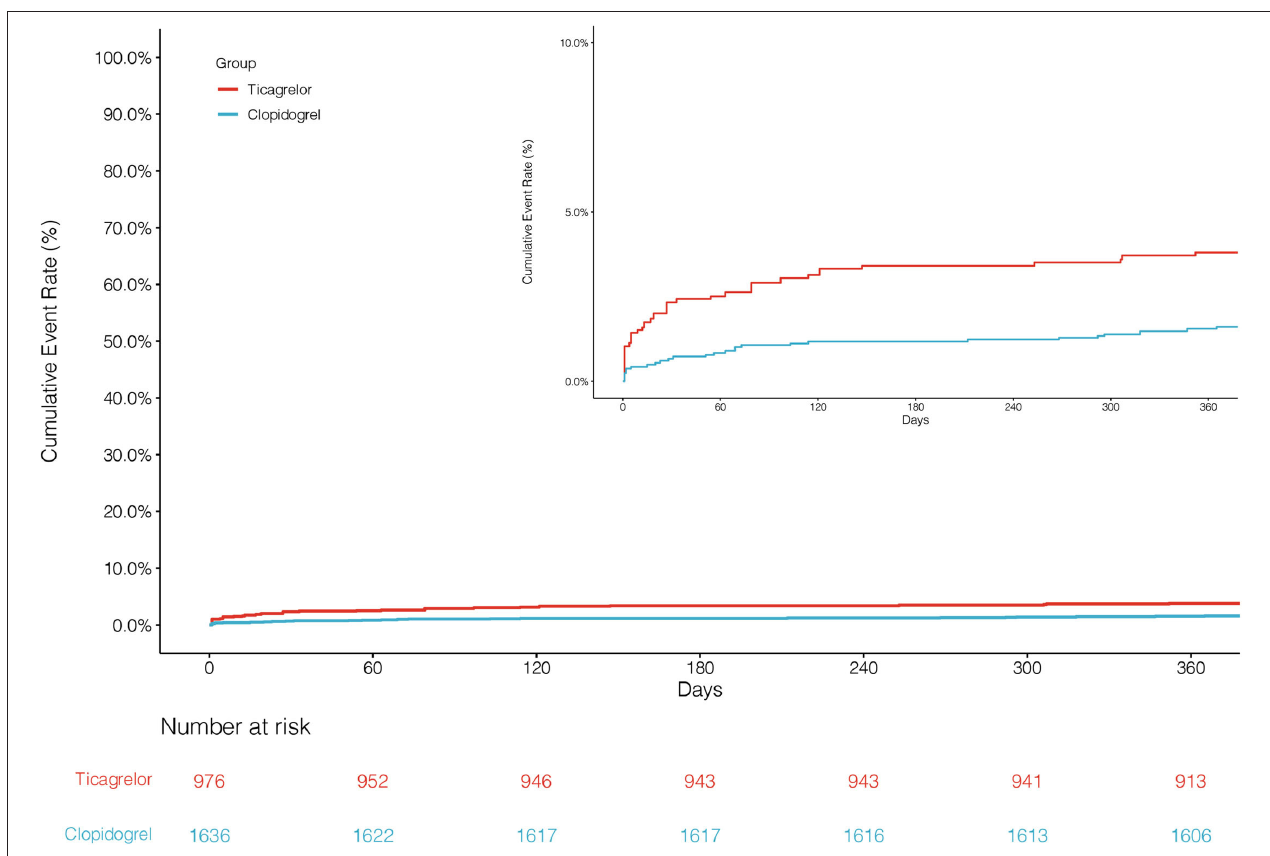
FIGURE 4 | Cumulative incidence of clinically significant bleeding after inverse probability of treatment